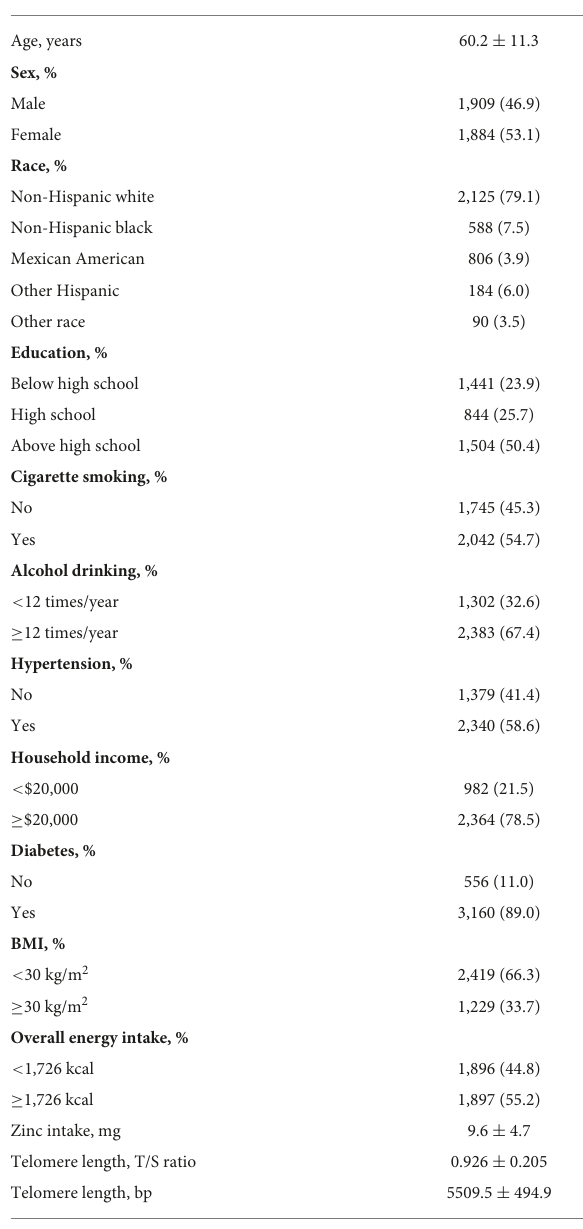
TABLE 1 Characteristics of the participants ( N =